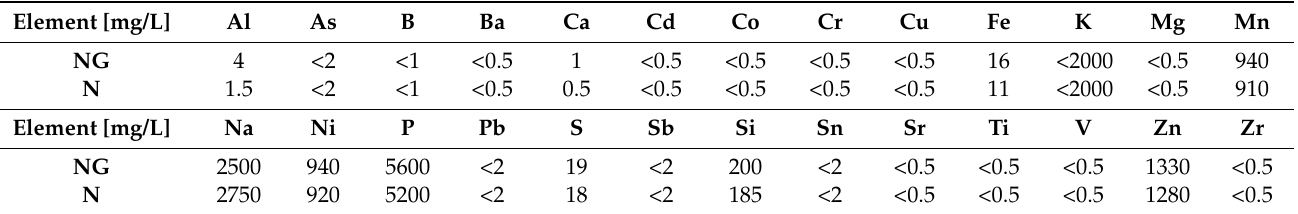
Table 2. The chemical composition of phosphating bath with nitrite (N) and nitroguanidine (NG) accelerator.